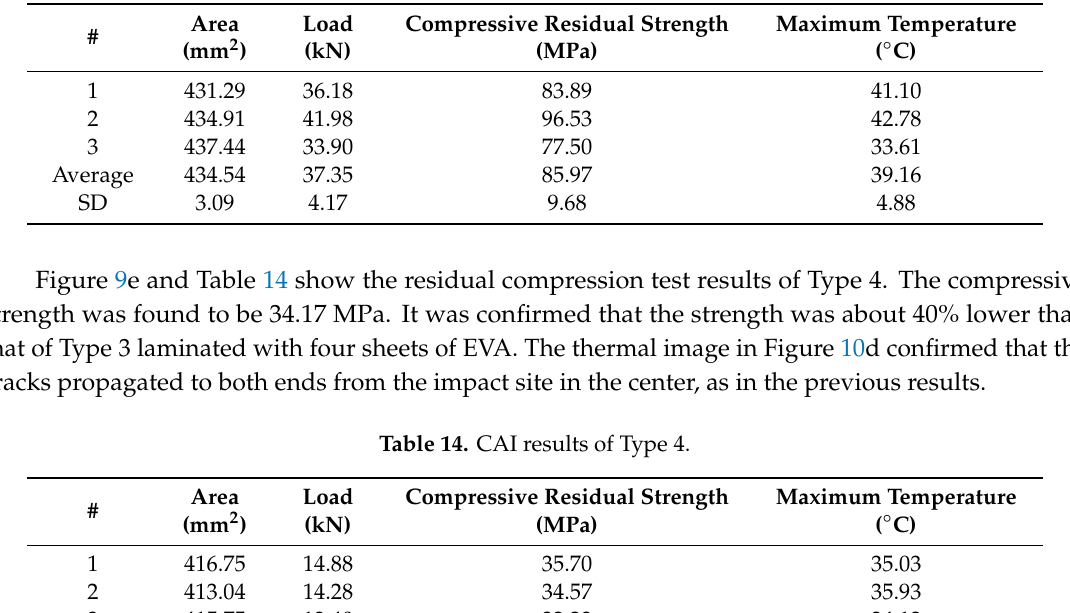
Table 13. CAI test results of Type 3.